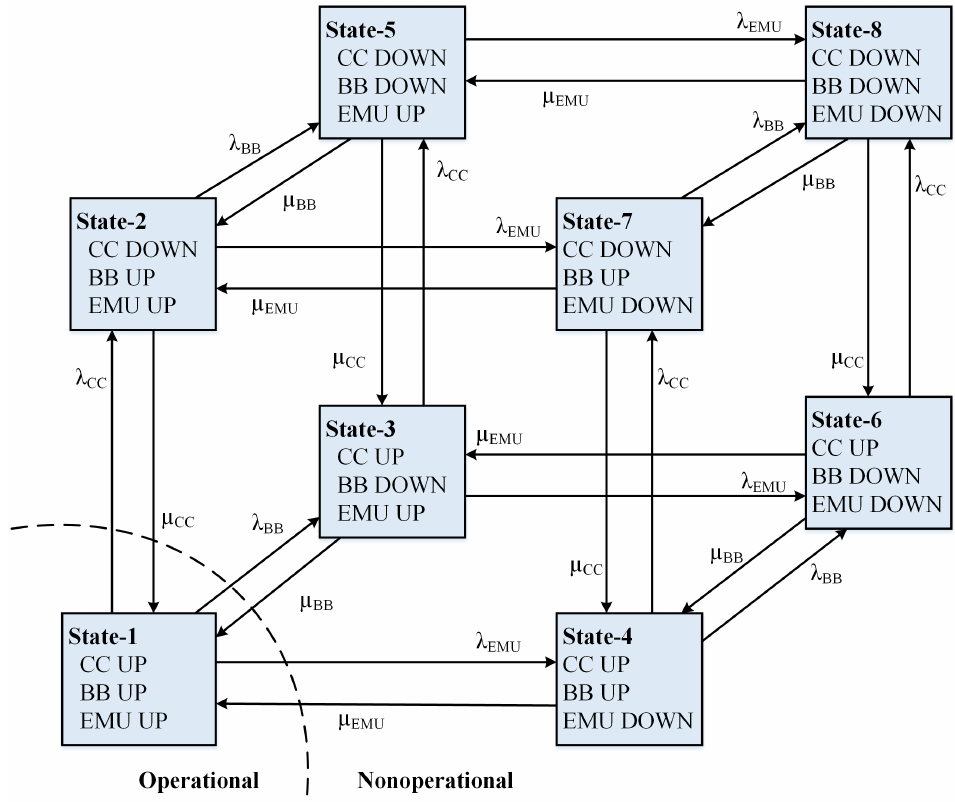
Figure 4. State-space diagram of the Energy Source Subsystem. Equation (9) shows the STPM of a three-components